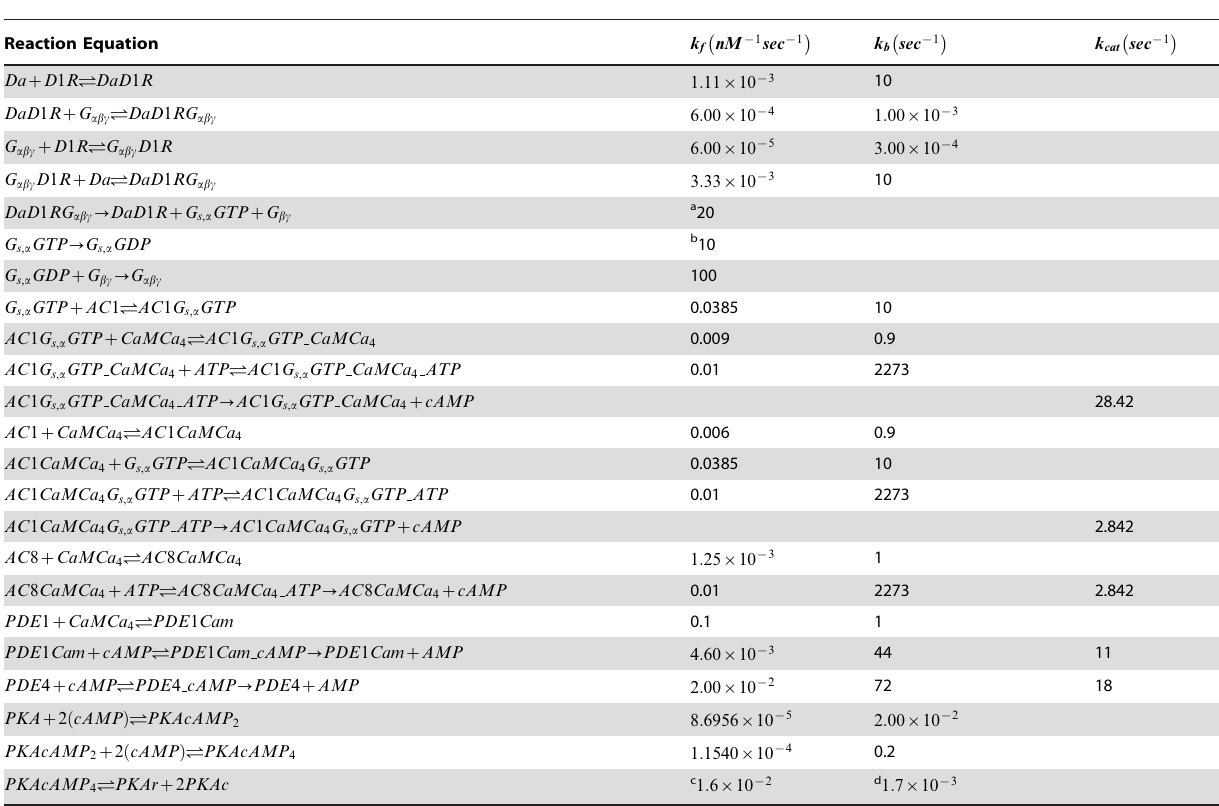
Table 1. Reactions and rate constants of the dopamine activated pathway.